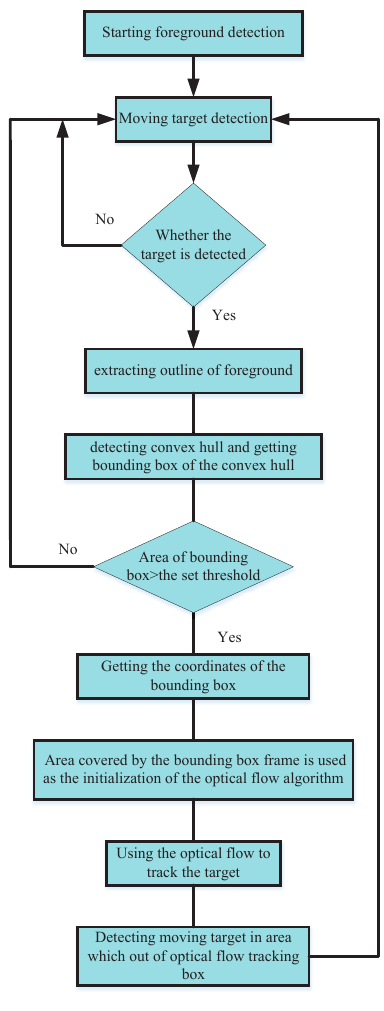
Figure 6. The algorithm